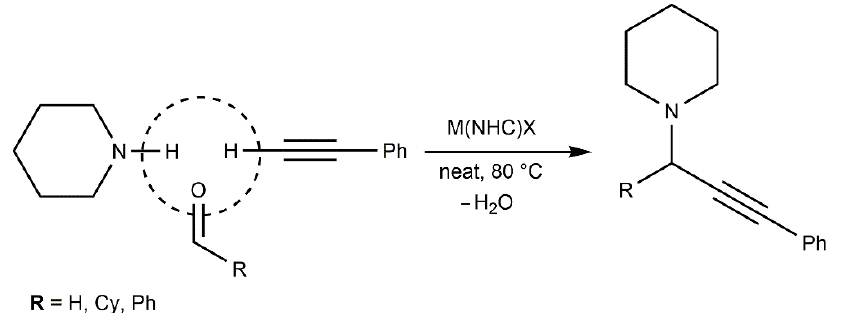
Scheme 2. A 3 -coupling reaction to give propargylamine PAA (PAA1 where R = H; PAA2 where R = cyclohexyl; PAA3 where R = phenyl). Table 1. Catalytic activity of Ag-NHC and Au-NHC in A 3 -coupling